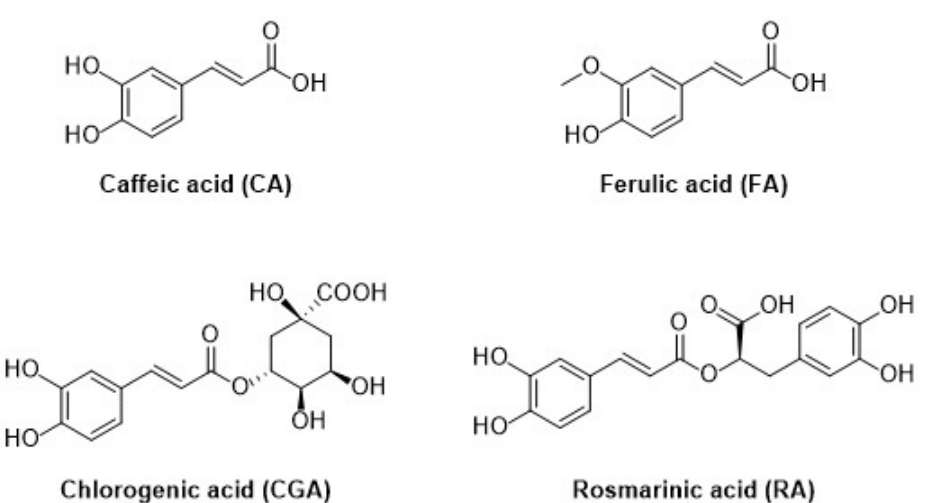
Figure 7. Schematic representation of the hydroxycinnamic acids and derivatives considered in this review .